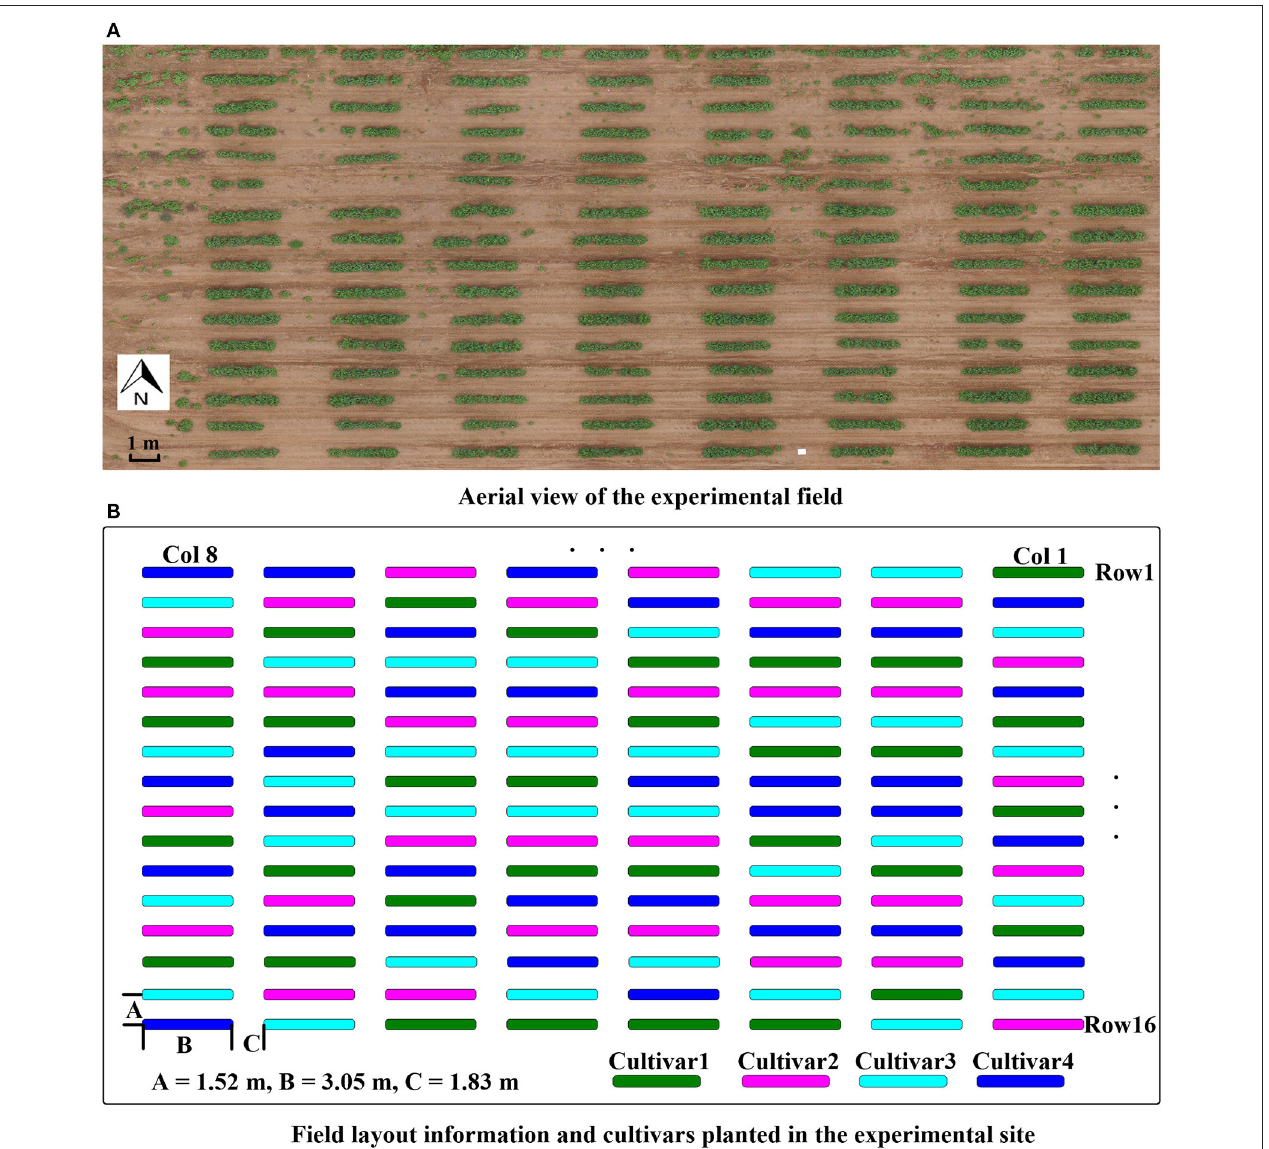
FIGURE 1 | Experimental field layout. (A) Aerial view of the experimental field; (B) illustration of experimental design with cultivar and field layout